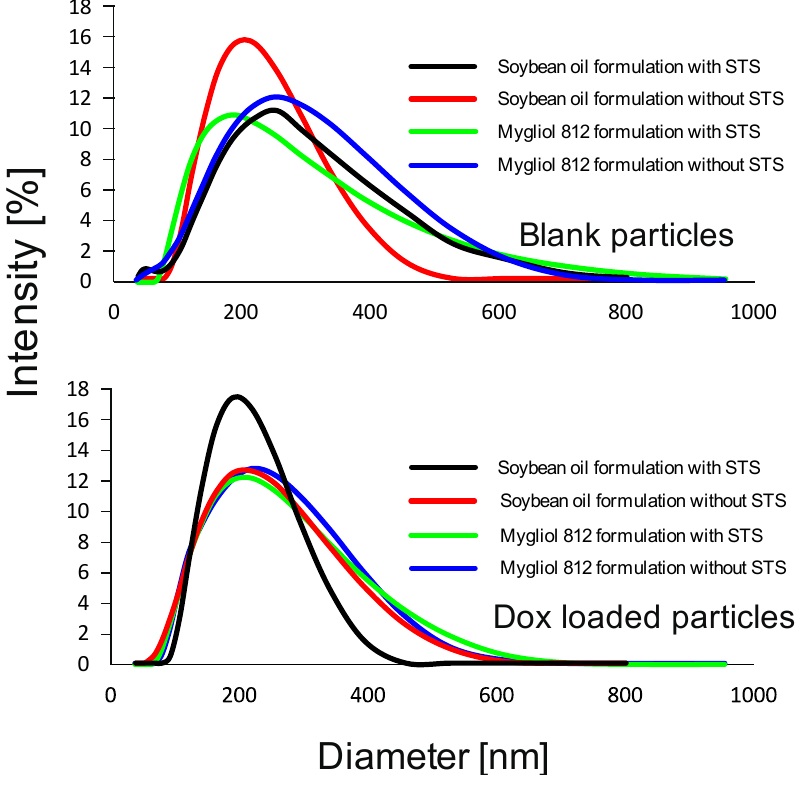
Figure 1. Freshly prepared carrier systems display a peak hydrodynamic particle size of approximately 200 nm. Freshly prepared particles (blank: top panel; doxorubicin (Dox)-loaded particles: bottom panel) were diluted 1:2500 in particle-free water and measured using a Malvern particle size reader. The distribution of the hydrodynamic particle size (in nm) is plotted against the intensity (in %). Individual preparations are denoted by black: soybean oil formulation with sodium tetradecyl sulfate (STS); red: soybean oil formulation without STS; green: Mygliol 812 formulations with STS; blue: Mygliol 812 formulations without STS.